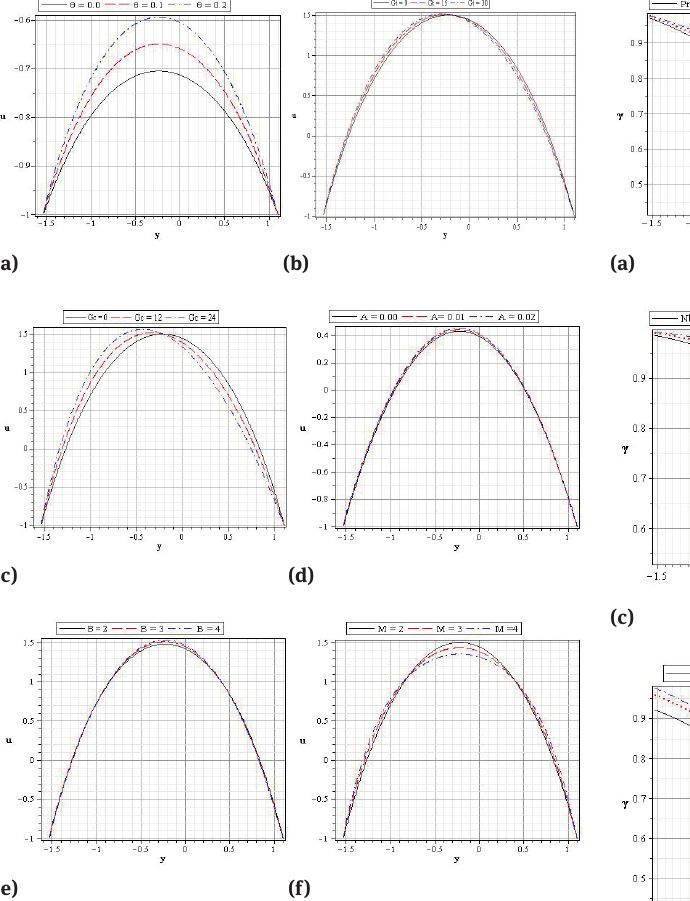
Fig. 2: Axial velocity u versus y for (a): x = 1, Gt = 0.5, Gc =